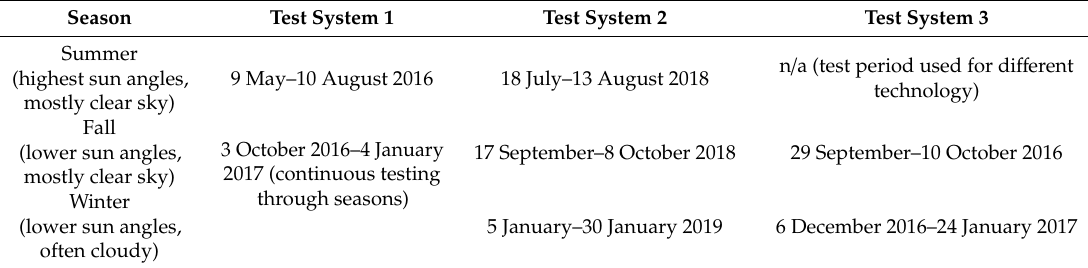
Table 3. Test period